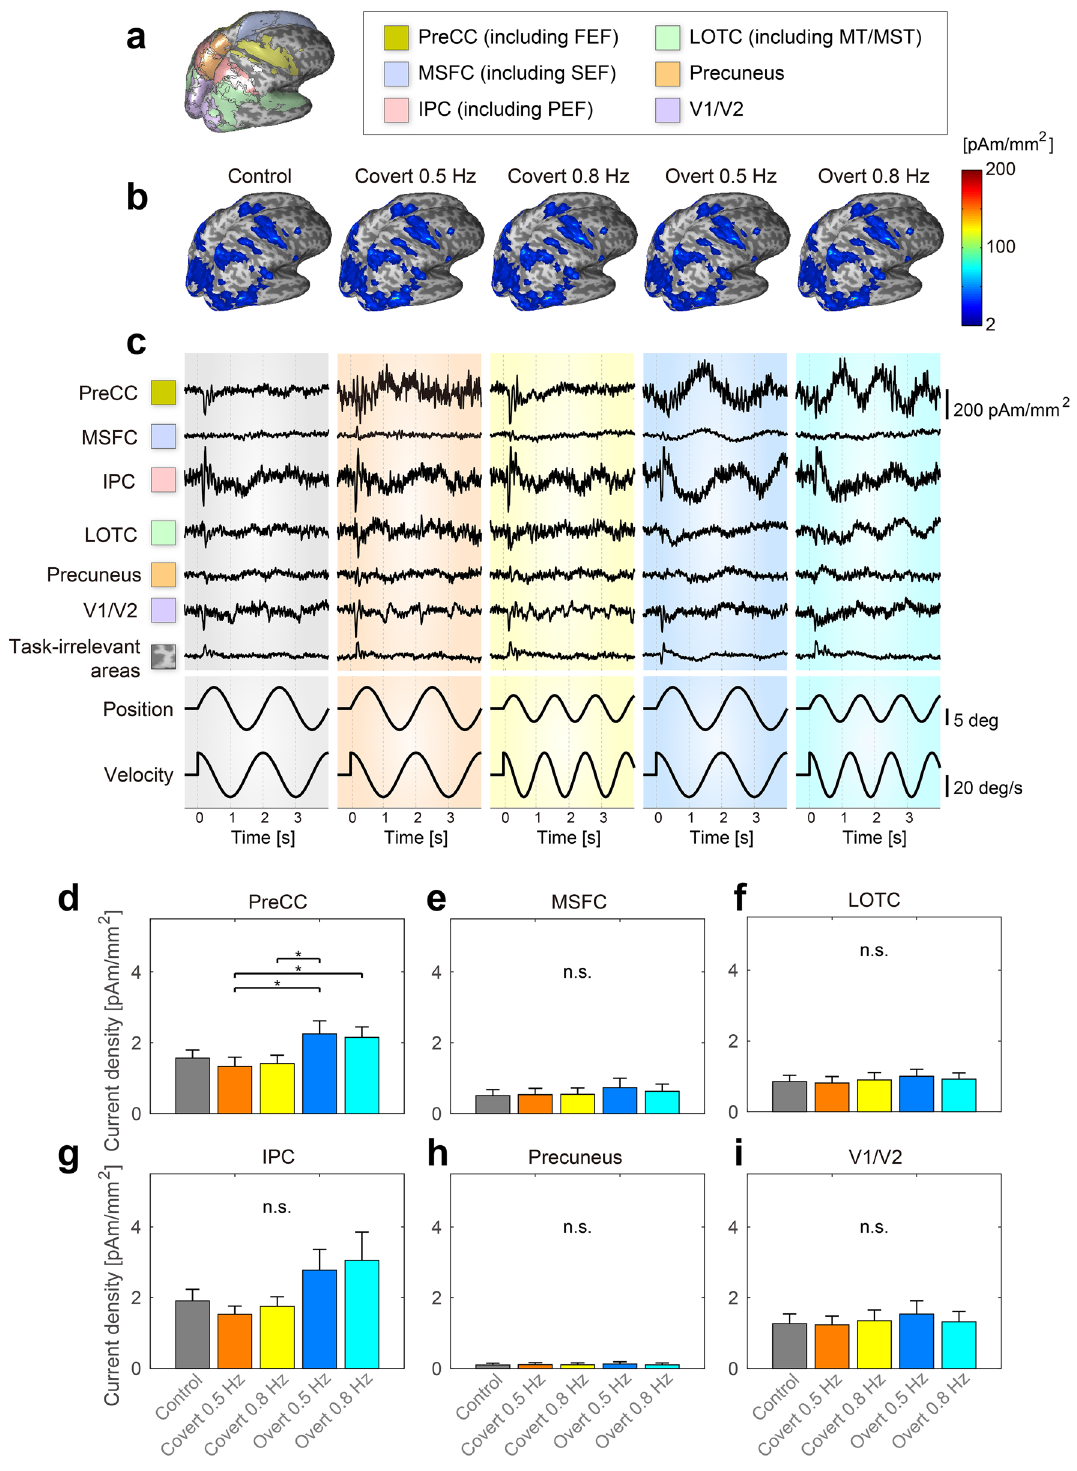
Figure 2. ( a ) Cortical regions of PreCC, MSFC, LOTC, IPC, Precuneus, and early visual area V1/V2. ( b ) Spatial–temporal characteristics of estimated cortical currents (an example of a typical participant). ( c ) Examples of the time series of estimated cortical currents. Starting from the left, we showed the results of the following conditions: control, covert 0.5 Hz, covert 0.8 Hz, overt 0.5 Hz, and overt 0.8 Hz. ( d – i ) Comparisons of current densities among five different tasks: ( d – i ) show PreCC, MSFC, LOTC, IPC, Precuneus, and V1/V2 results, respectively. * indicates a significant difference of multiple comparisons among five tasks at difference level